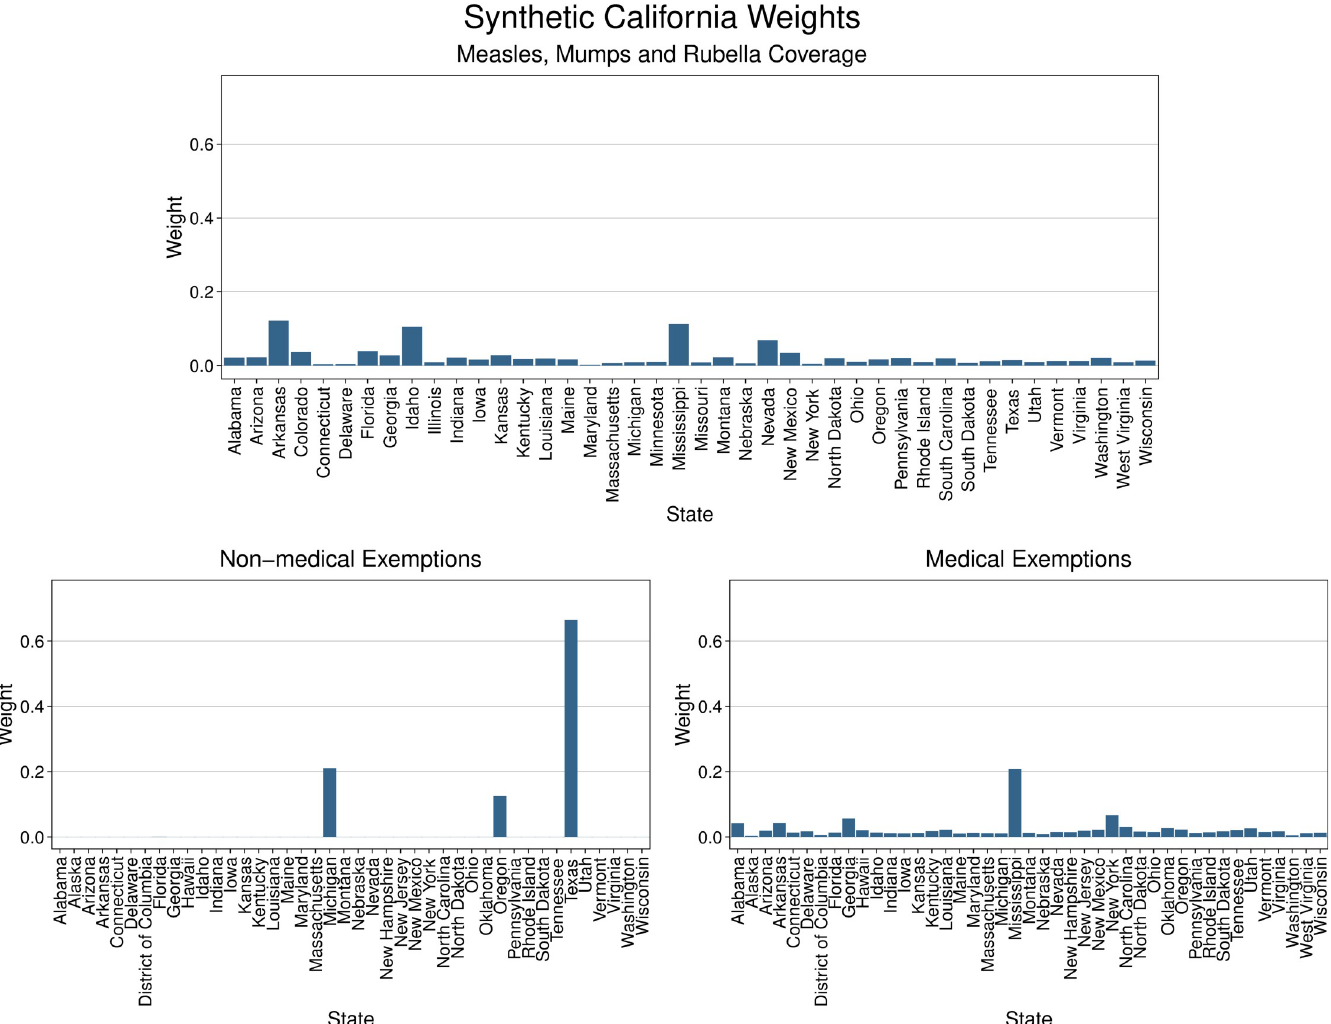
Fig 2. Weights of the control states to construct the “synthetic control California” for state-level analysis of three study outcomes. The synthetic control California was constructed as a hypothetical control state from a weighted sum of the untreated states (i.e. the control pool). The weights were calibrated to match the prepolicy vaccine outcome for California. This figure shows the weights of the control states for each of the three outcomes: MMR coverage (top), nonmedical exemptions (bottom left), and medical exemptions (bottom right). MMR, measles, mumps, and rubella.